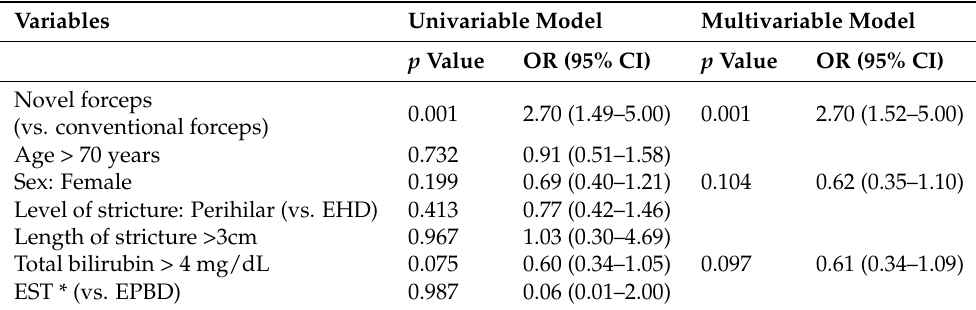
Table 3. Variables for diagnostic accuracy according to univariable and multivariable logistic regres- sion